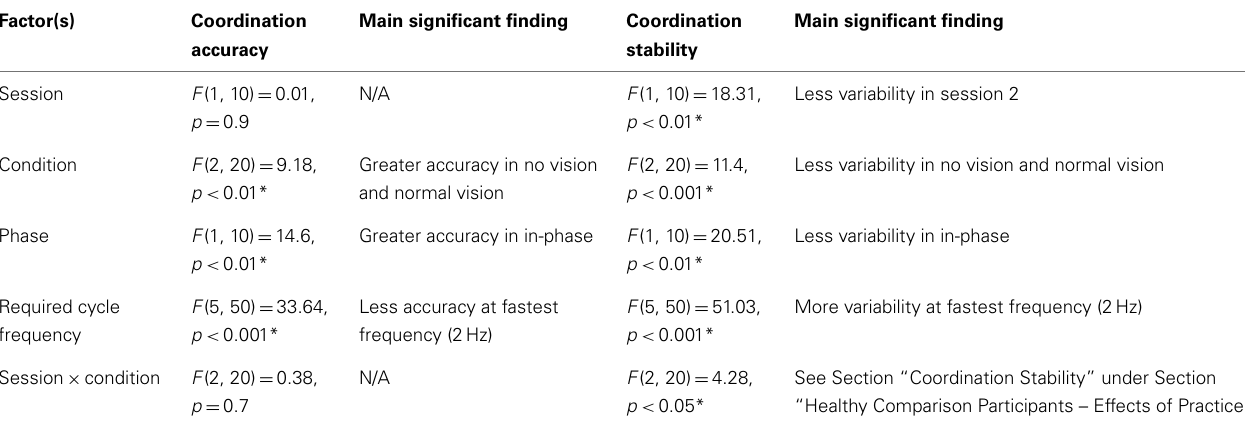
TableA5 | Statistical results fromANOVA analysis on planned comparison between session 1 and session 2 of healthy comparison (HC) participants to evaluate the effects of practice on coordination accuracy and